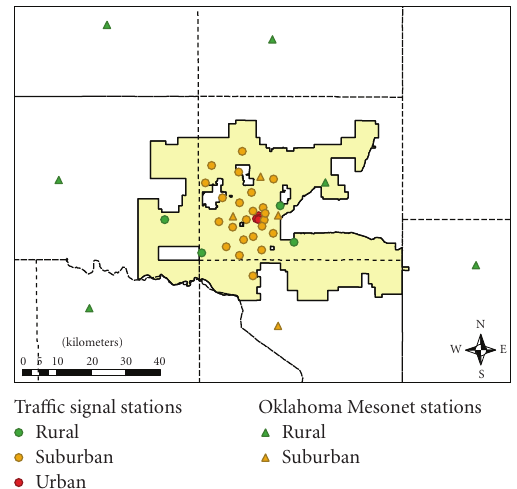
Figure 1: The locations of Oklahoma City Micronet and Oklahoma Mesonet sites used as part of the study. The highlighted area (tan) represents the municipal boundaries for the City of Oklahoma City and the dashed lines represent county borders. The urban sites consisted of locations classified by UCZ1 and UCZ2 [40], the suburban areas included sites classified as UCZ3 through UCZ6, and the rural sites included locations with limited structures consisting mainly of large expanses of native, short grass vegetation, interspersed trees, rangeland, and cropland (winter